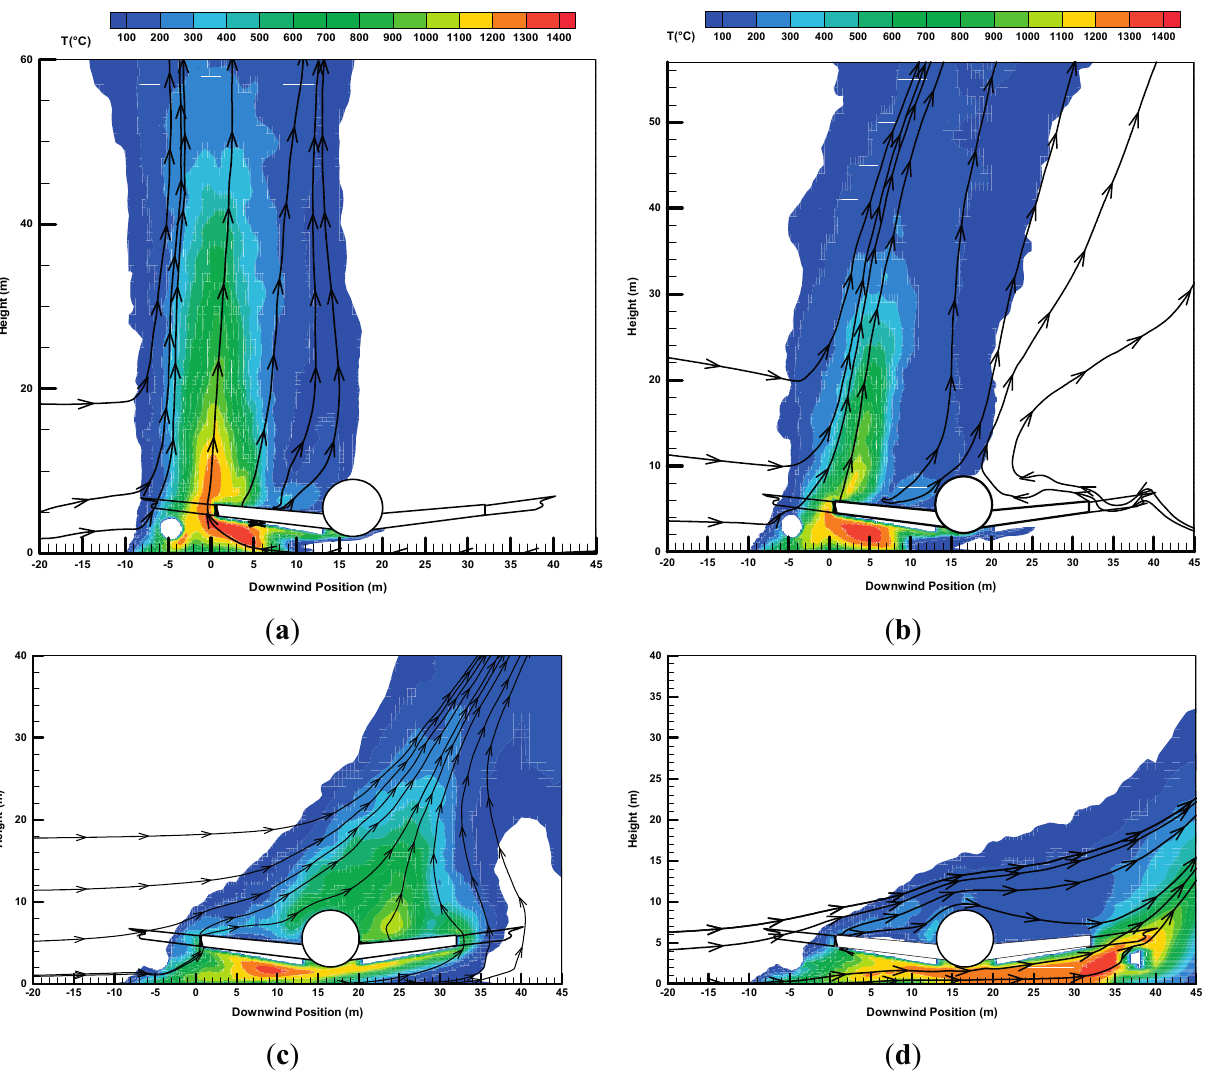
Figure 13. Contours of the time-averaged temperature for fires containing an aircraft of the composite type. ( a ) Quiescent condition; ( b ) low wind speed of 2 m/s; ( c ) medium wind speed of 5 m/s; ( d ) high wind speed of 10